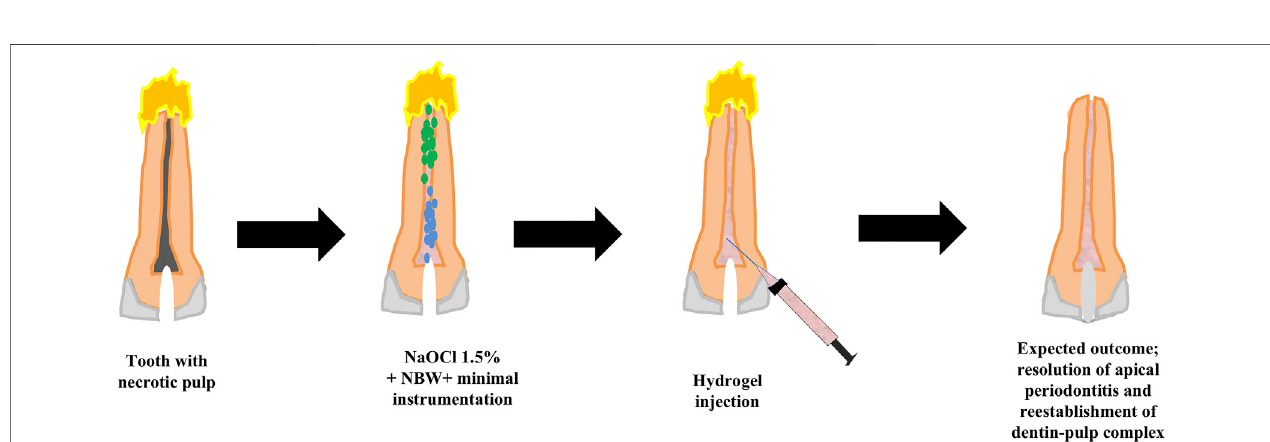
FIGURE 2 | Showing the suggested clinical protocol of MIREPs. A traumatized permanent tooth with a necrotic pulp and periapical disease would be accessed using a contracted Endodontic Cavity design. This would be followed by combined irrigation of 1.5% sodium hypochlorite and nanobubble water to disinfect the canal, dislodgebio fi lmsandreleasesequesteredgrowthfactors.ExtracellularMatrix-basedhydrogelwouldthenbeinjectedintothepulpspaceandthetooth fi nallysealedwith bioceramic material and restored by composite